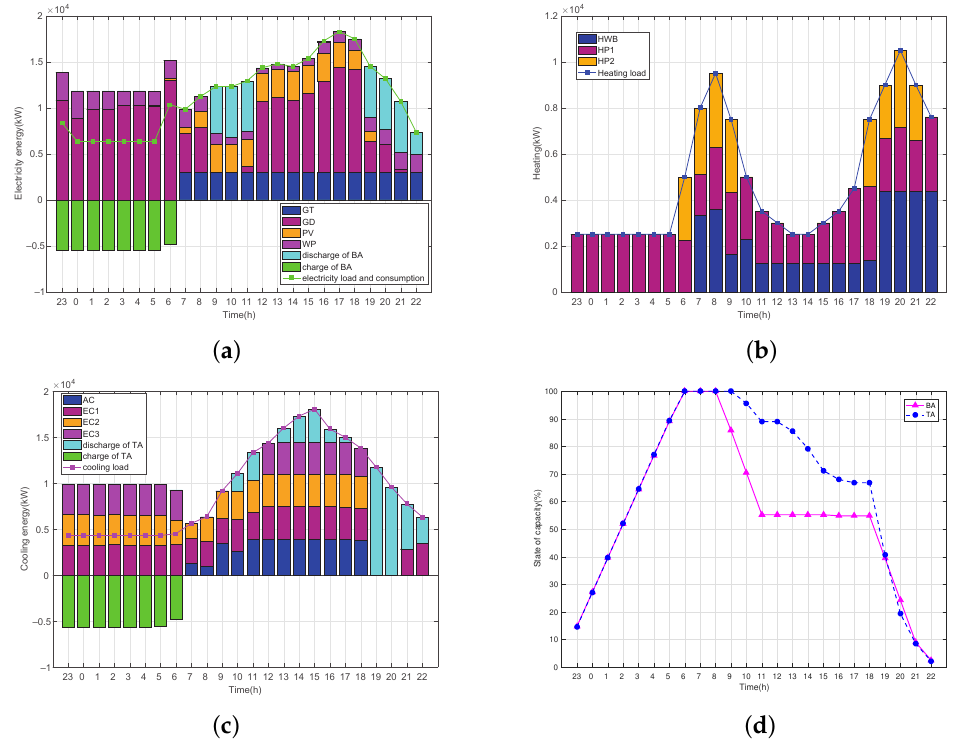
Figure 7. The optimal generation scheduling results in Case 1 from the perspective of energy analysis. ( a ) the electrical power allocation among multiple devices; ( b ) the heating energy allocation among multiple devices; ( c ) the cooling energy allocation among multiple devices; ( d ) the curves of the energy stored in the TA and